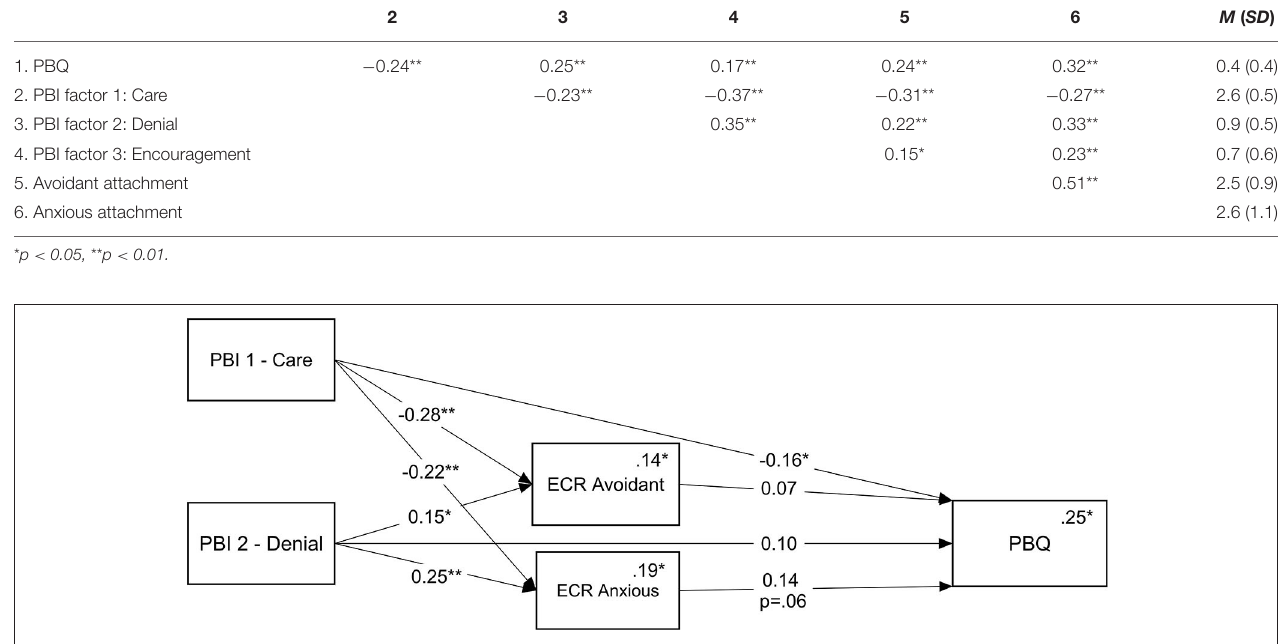
FIGURE 3 | Final mediation model; ECR (anxious attachment orientation) mediating the association between PBI factors (parental bonding care and denial of autonomy) and PBQ. * p < 0.05, ** p < 0.01 . While not shown on the graph, this model was analyzed with being primiparous, education, and having a psychiatric diagnosis as covariates. Numbers above the lines are standardized regression weights, and numbers above the endogenous variables and multiple squared